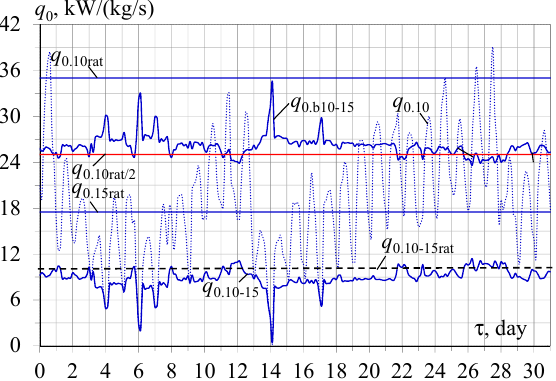
Figure 7. Actual values of refrigeration capacities q 0.10 required for conditioning outdoor air to 10 ◦ C; the values q 0.10–15 for further air conditioning from 15 to 10 ◦ C; residual booster values q 0.b10–15 : q 0.b10–15 = q 0.10rat − q 0.10–15 ; q 0.10–15 = q 0.10 − q 0.15 .